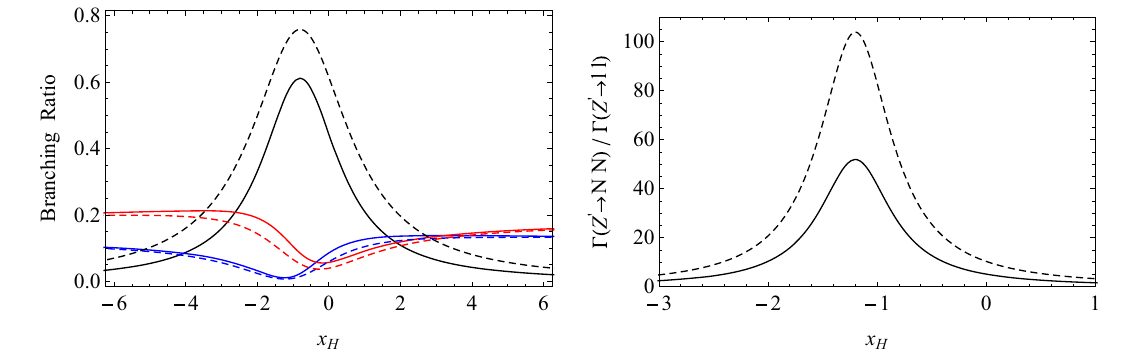
Fig. 3 For the alternative U ( 1 ) X model, the left panel shows the branching ratios of Z (cid:2) as a function of x H with a fixed m Z (cid:2) = 3 TeV. The solid lines correspond to m N 1 = m Z (cid:2) / 4 and m N 2 > m Z (cid:2) / 2, and the dashed lines correspond to m N 1 , 2 = m Z (cid:2) / 4. From top to bottom, the solid (red, black and blue) lines at x H = − 1 are the branching ratios to the first generations of jets (up and down quarks), RHNs, and charged